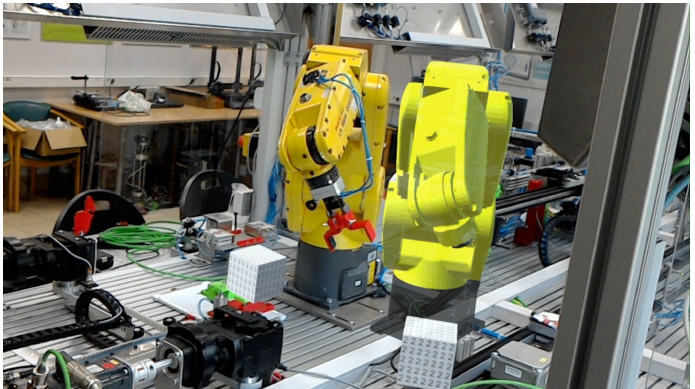
Figure 1. A physical 6-axis robot with its interactive Digital Twin displayed with MR